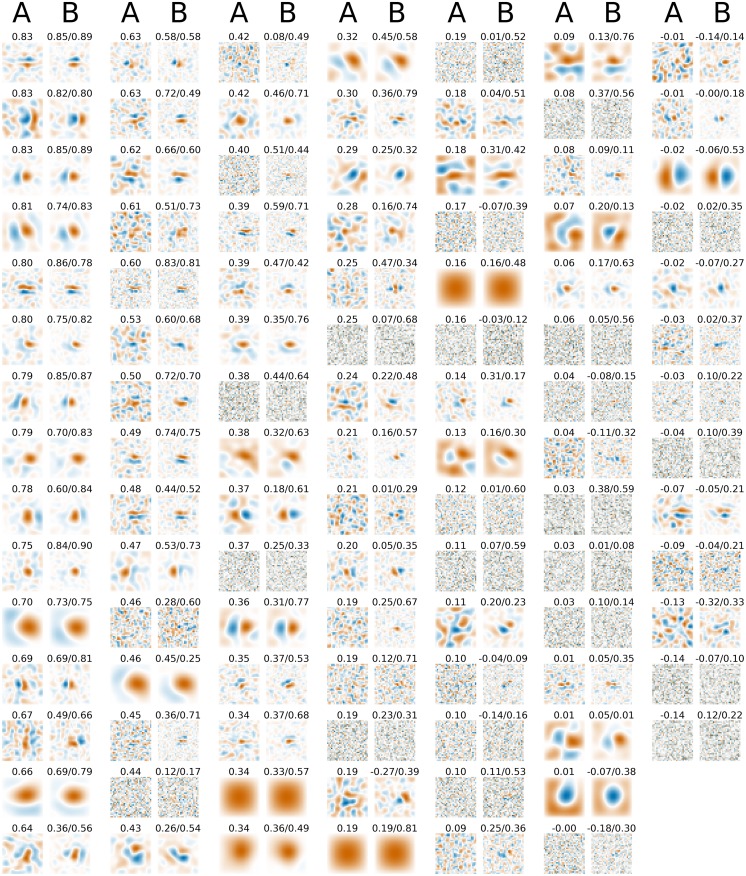
Linear components of RFs estimated with HSM are consistent with rLN-derived RFs.For neurons where RFs can be discerned from the noise, the rLN model produces very similar RFs for both experimental responses (A columns) and HSM responses (B columns), indicating that the HSM is compatible with the RFs estimated by rLN. The numbers above the rLN filters obtained directly from data (A columns) show the performance (R) of the rLN model for the corresponding neuron. The two numbers above the rLN filters obtained using the prediction of the HSM (B columns) indicate the performance of the rLN model derived from the HSM prediction (before slash) and the performance of the full HSM for the corresponding neuron (after slash).